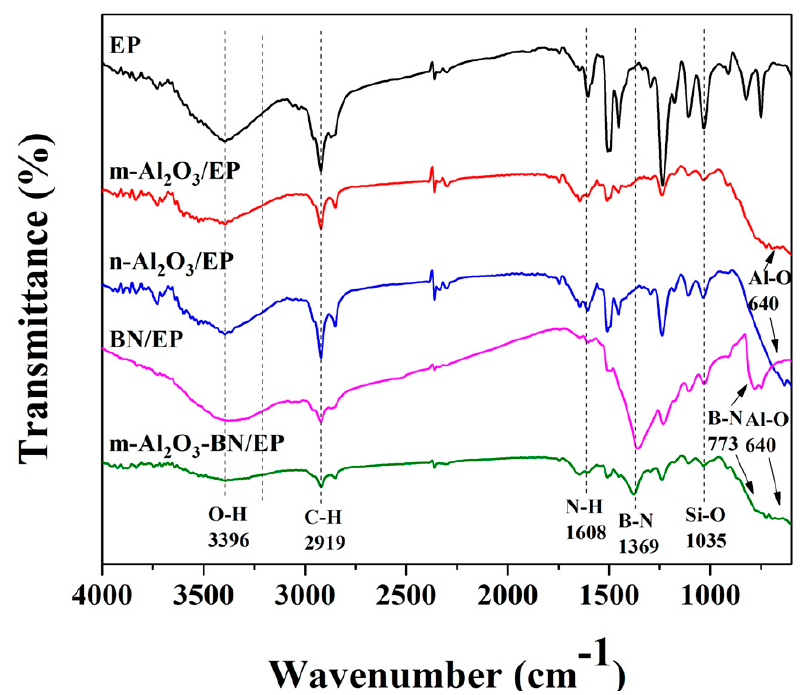
Figure 4. FTIR spectra of different EP composites.